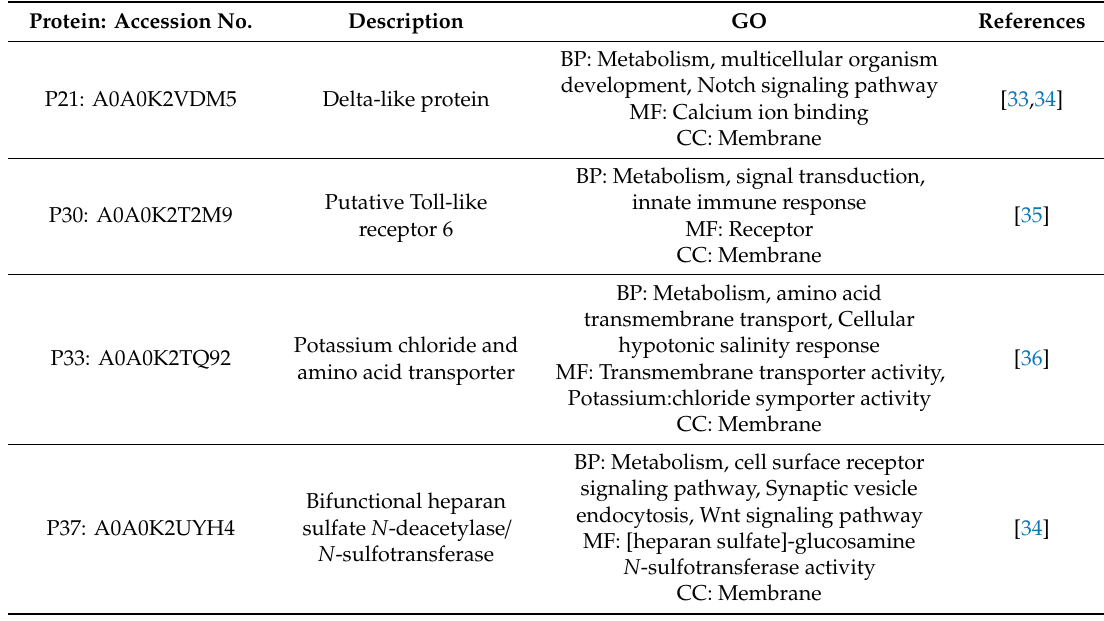
Table 1. Proteins selected as candidate vaccine